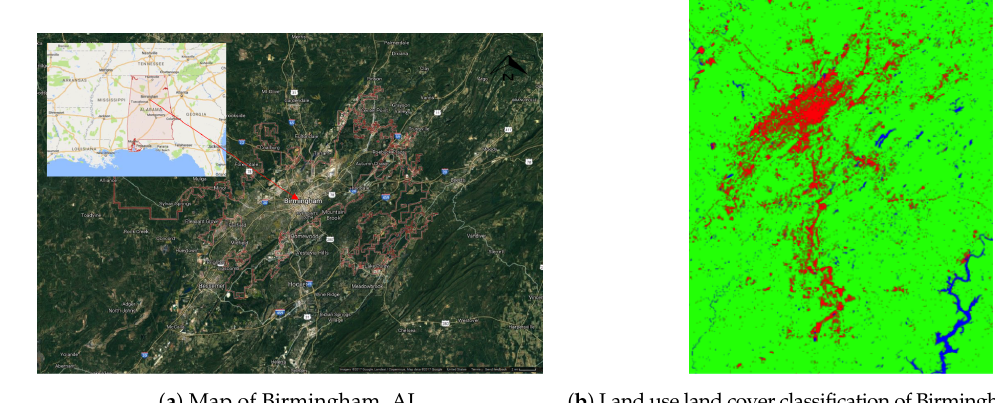
Figure 9. The map of Birmingham, AL, USA in ( a ), in relative to Alabama and the US, adopted from Google Earth Imagery; The land use land cover classification of Birmingham, AL, in ( b ) with red for urban, green for rural and blue for water